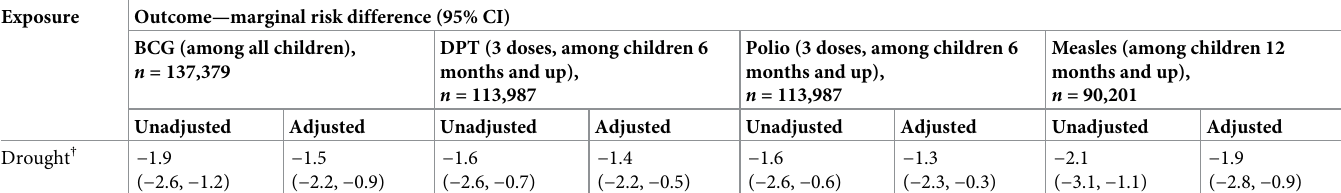
Coefficients are presented as marginal risk differences in percentage points derived from logistic regression models, with 95% confidence intervals in parentheses. The unadjusted model includes country-level fixed effects. The adjusted model includes child sex, birth month, and birth order; mother’s age (15–19, 20–29, 30–39, or 40–49 years), mother’s literacy (literate versus not literate), mother’s education, and mother’s marital status; and household wealth index (quintiles), household size, and urban residence. Standard errors are clustered at the enumeration area level. † For BCG, DPT, and polio vaccination, the exposure period for drought was the 12 months prior to the date of birth. For measles, the exposure period was the 12 months prior to the child’s first